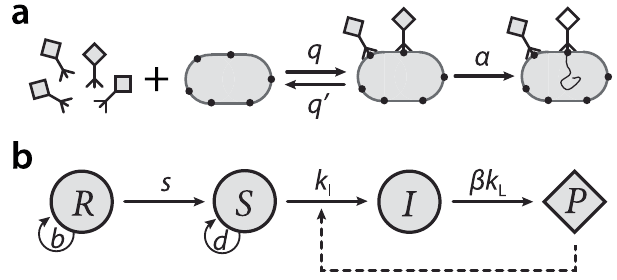
Fig. 1 Phage-host molecular interactions and population dynamics. ( a ) Molecular interactions. The phage diffuses onto a host that expresses phage receptors (solid circles), binds reversibly to a receptor and infects the cell by injecting its DNA. Reaction rates are shown on arrows; the phage binding and unbinding rates q and q 0 and phage absorption rate α are de fi ned per receptor. ( b ) Population dynamics for a preventative defense model. The resistant phenotype R generates phage-sensitive cells S at rate s , on which the phage P grows. I labels cells infected by phage. Arrows indicate rate constants for each type of transition; the circular arrows indicate the growth rates of R and S cells (respectively, b and d ) with d − b > 0 being the cost of resistance. For immune defenses, all phenotypes express receptors and absorb phage, but only sensitive cells transition to infection and